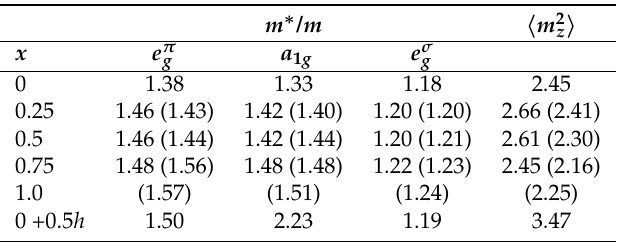
Table 2. Orbitally-resolved enhancement of the band mass, m ∗ / m , and the instant squared magnetic moment, (cid:104) m 2 z (cid:105) , for two types of iron atoms in FeO 2 H x for different orbitals of the d shell as obtained by DFT+DMFT at β = 10 eV − 1 (data for the second type of Fe are in parenthesis). The last row shows the result for FeO 2 doped with 0.5 of hole.